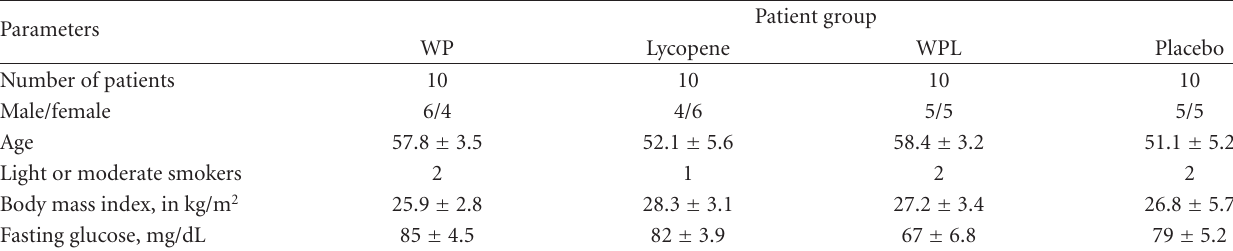
Table 1: Clinical groups.